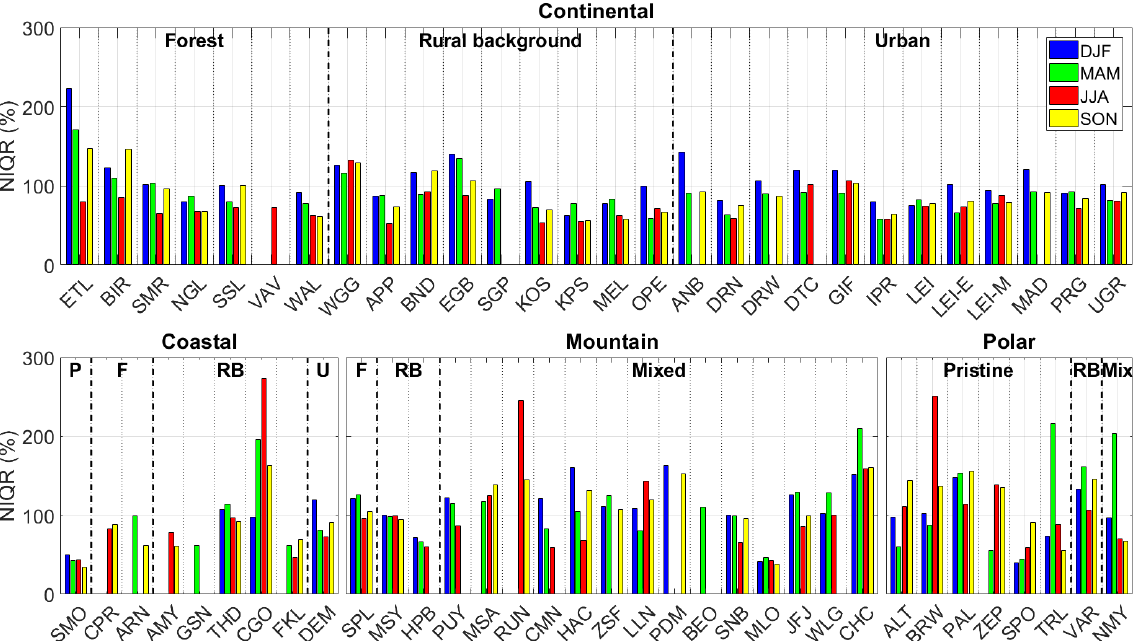
Figure 7. Intra-seasonal variability of N tot . Stations are sorted based on the classification reported in Table 1. The meaning of the abbre- viations used for the footprint is the following: P for pristine, F for forest, RB for rural background, U for urban and Mix for mixed. Explanations regarding the calculation and interpretation of the NIQR are available in Sect.